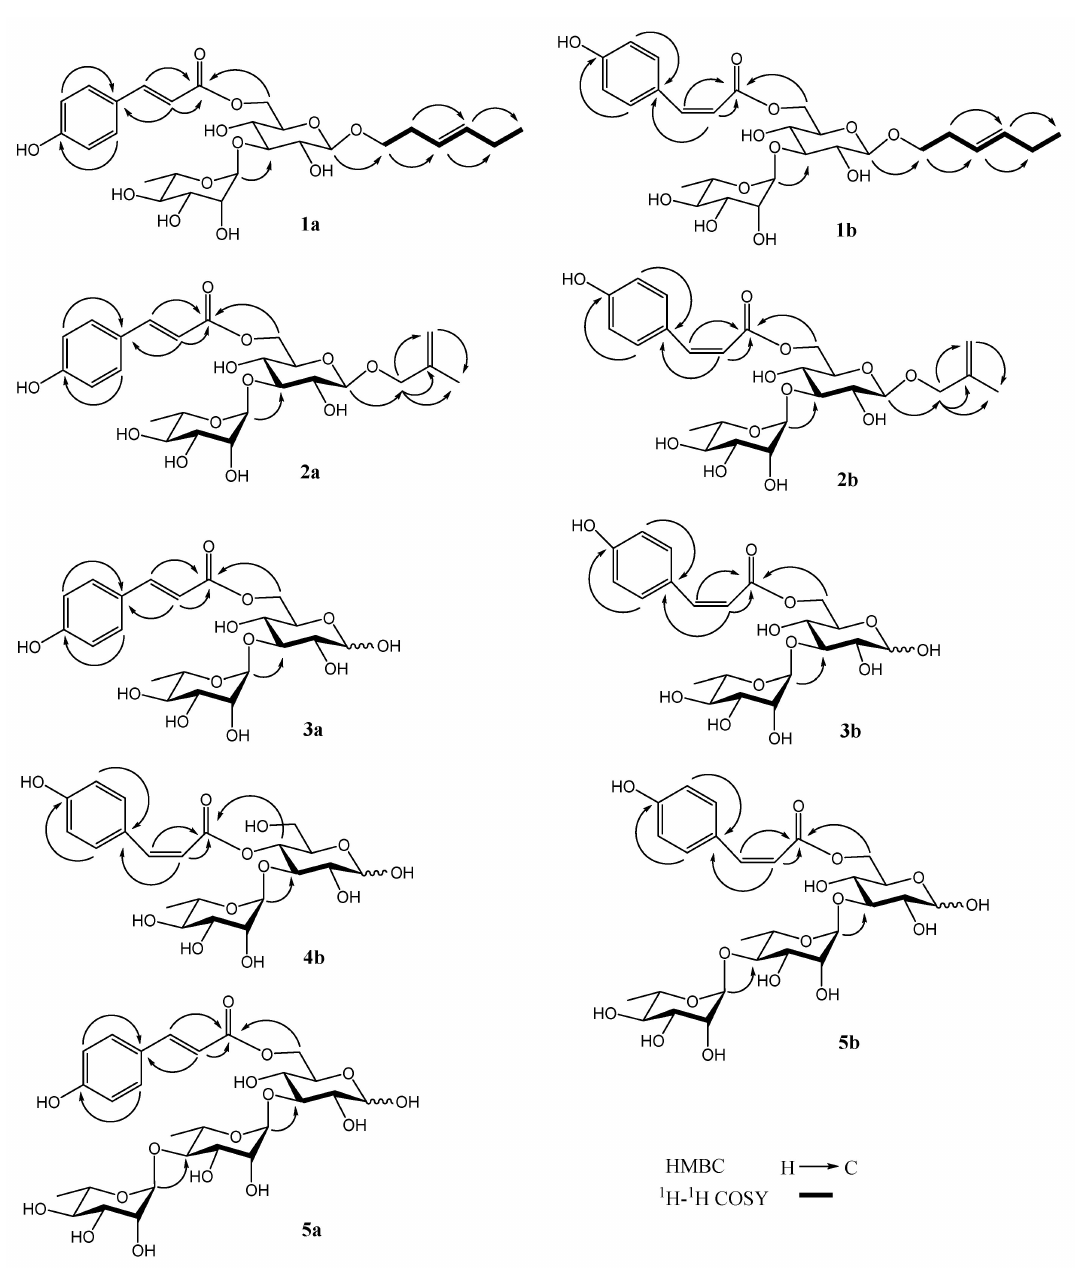
Figure 2. Key HMBC and 1 H- 1 H COSY correlations of compounds 1 – 5 . Compound 2 was obtained as a white amorphous powder, and its molecular formula was determined as C 25 H 34 O 12 by HRESIMS ( m/z 549.1941 [M + Na] + , calculated 549.1948 for C 25 H 34 NaO 12 ). The NMR spectra of 2 showed two stereoisomers: 2a and 2b (2:1). In the 1 H NMR spectrum of 2a (Table 1), the following signals were revealed: (1) a 4-substituted phenyl at δ H 6.80 and 7.47 (2H each, d, J = 8.4 Hz); (2) a trans double bond at δ H 6.37 and 7.65 (1H each, d, J = 16.2 Hz); (3) two olefinic proton signals at δ H 4.88 and 5.02 (1H each, br. s); (4) two anomeric protons at δ H 4.30 (1H, d, J = 7.2 Hz) and 5.18 (1H, d, J = 1.8 Hz); (5) a methylene linking with oxygen at δ H 4.07 and 4.20 (1H each, d, J = 12.6 Hz); and two methyl groups at δ H 1.75 (3H, s) and 1.25 (3H, d, J = 6.6 Hz). In the 13 C NMR